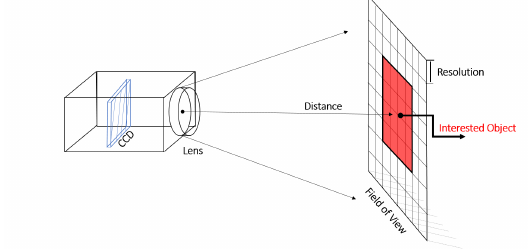
Figure 2. Resolution of visual system